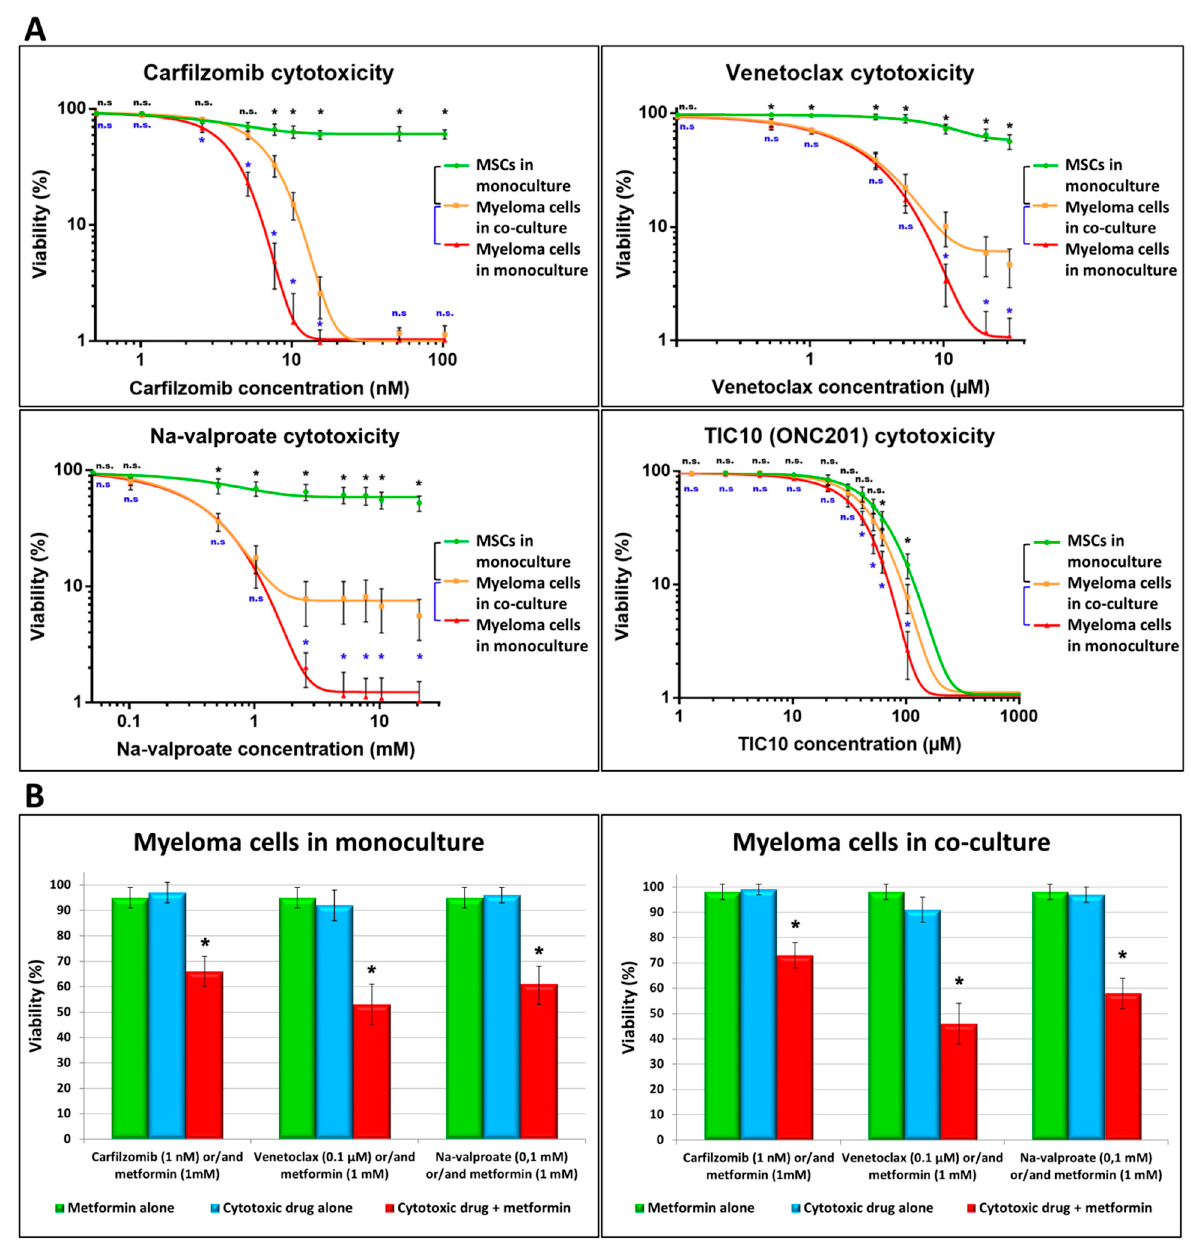
Figure 1. Effect of BM-MSCs on the cytotoxicity of drugs exerted on MMs. Cells (1 × 10 3 BM-MSC/well, 1 × 10 4 myeloma cell/well in monocultures or MM–BM-MSC co-cultures) were incubated for 72 h in the absence or presence of various drugs then labeled with Hoechst 33,342 and propidium iodide. Cell death was analyzed with a high-content screening method using an automated digital microscope system (A and B). ( A ) Cytotoxicity of different concentrations carfilzomib, venetoclax, Na-valproate, and TIC10 was determined in MMs (red line) and BM-MSC (green line) monocultures or MM–BM-MSC (orange line) co-cultures. ( B ) The drugs (blue columns) carfilzomib (1nM), venetoclax (0.1 µM), Na-valproate (0.1 mM), and metformin (1 mM, green column) were added to the MM monoculture (left graph) or MM–BM-MSC co-culture (right graph) alone or in combination (red column). These results are representative of three independent experiments for one patient. The values are presented as mean ± standard deviation, p values < 0.05 were considered significant ( * ) while p values > 0.05 were considered non-significant